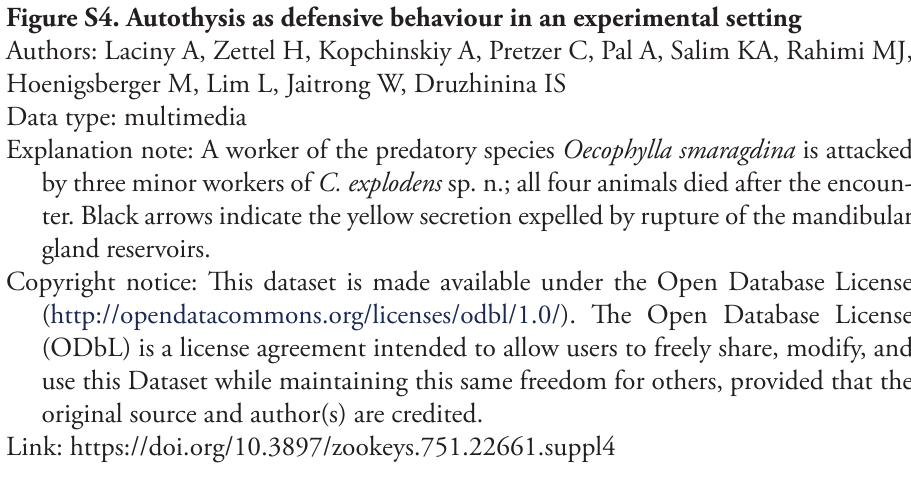
Figure S4. Autothysis as defensive behaviour in an experimental setting